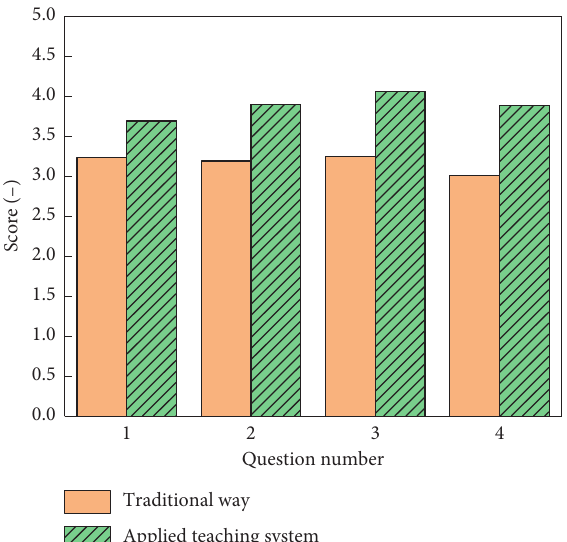
Figure 10: Questionnaire scores for I&P teaching attitude.